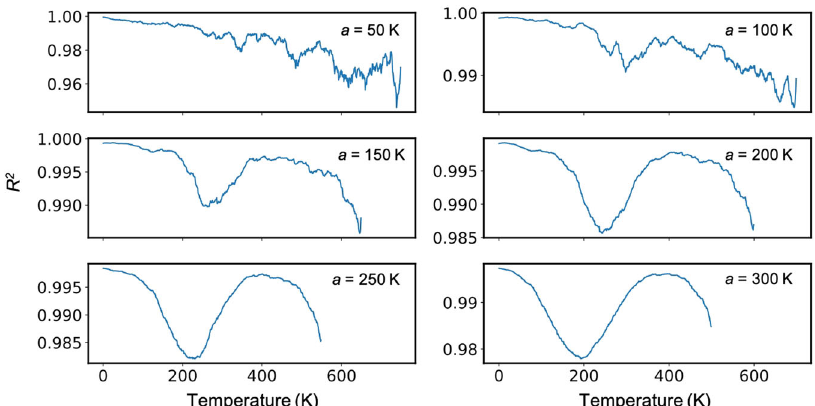
Fig. 3 The effect of fi tting ranges on R 2 – T plot. The R 2 – T plot for BCP compound with six different fi tting ranges. Each blue point in the plot represents an R 2 value fi tted with a range [ T , T + a ], where a = 50, 100, 150, 200, 250, and 300